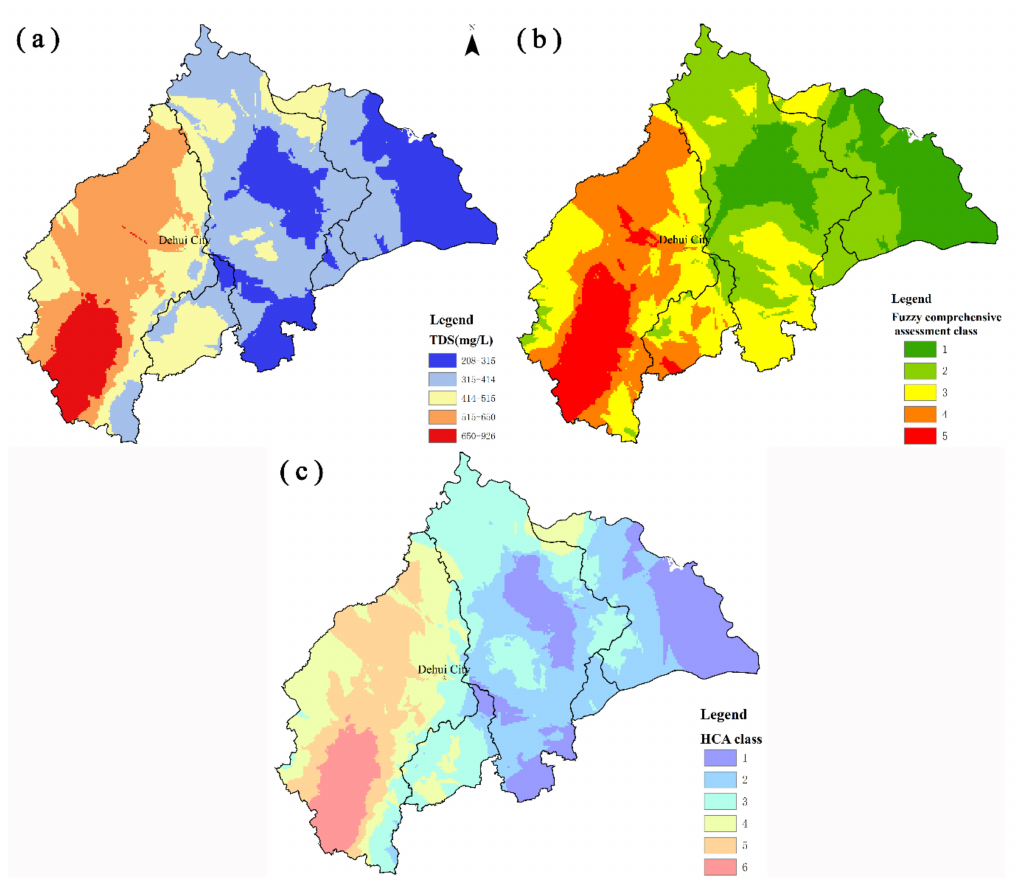
Figure 3. Spatial distribution map of the study area. ( a ) Total dissolved solids (TDS), ( b ) fuzzy comprehensive assessment grade and ( c ) HCA